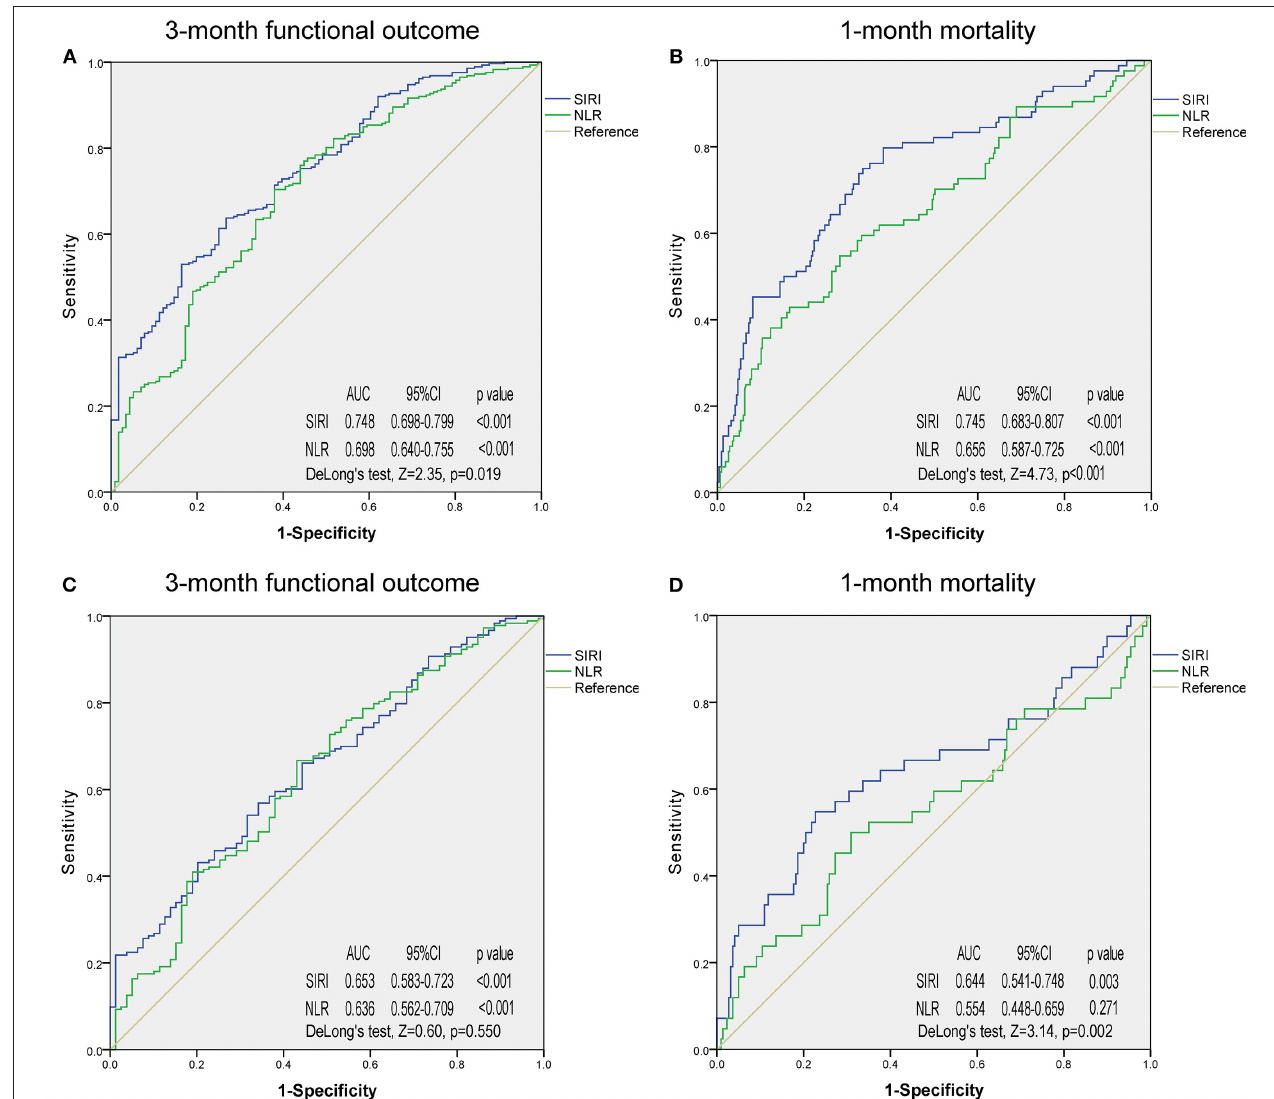
FIGURE 2 | Receiver operating characteristic curves of systemic inflammation response index and neutrophil-to-lymphocyte ratio for predicting 3-month functional outcome and 1-month mortality in the original cohort (A,B) and propensity score matching cohort (C,D) . SIRI, systemic inflammation response index; NLR, neutrophil-to-lymphocyte ratio; AUC, area under the